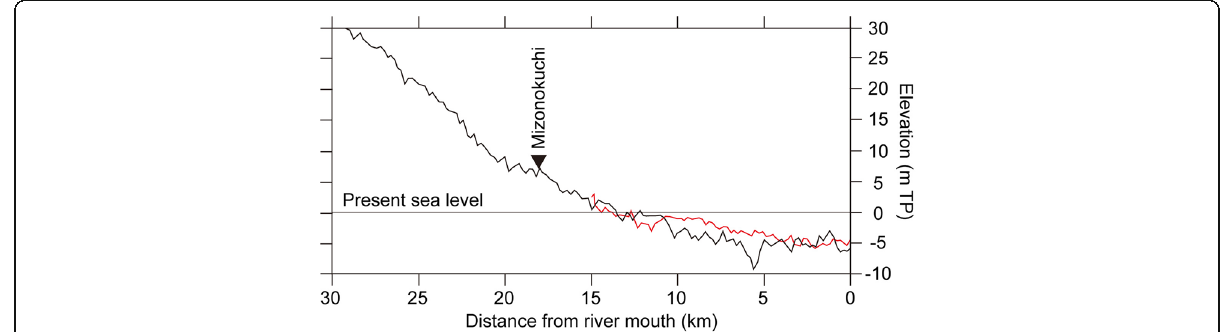
Fig. 4 Thalweg of the Tama (black line) and Tsurumi (red line) river beds. The knickpoint of the Tama River is at Mizonokuchi. The graph is based on Kanto Regional Development Bureau, Ministry of Land, Infrastructure, Transport and Tourism (2017a,